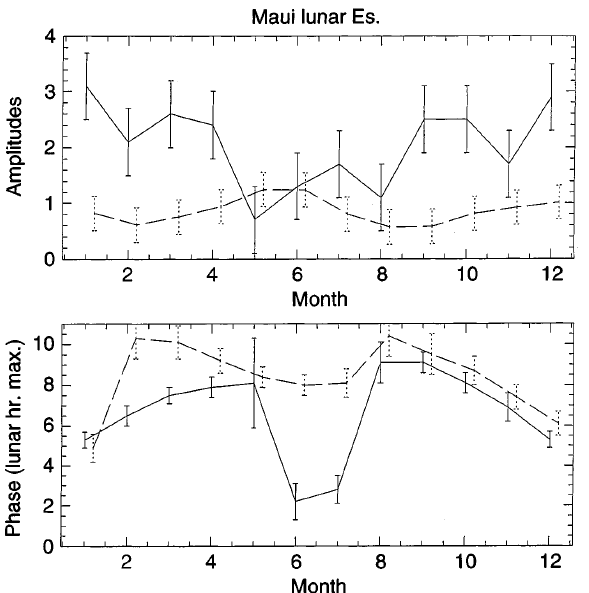
Fig. 8. Variation of amplitude and phase with season of the lunar tide in Es at Vanimo. Data are from 1976 to 1989. Other details are the same as